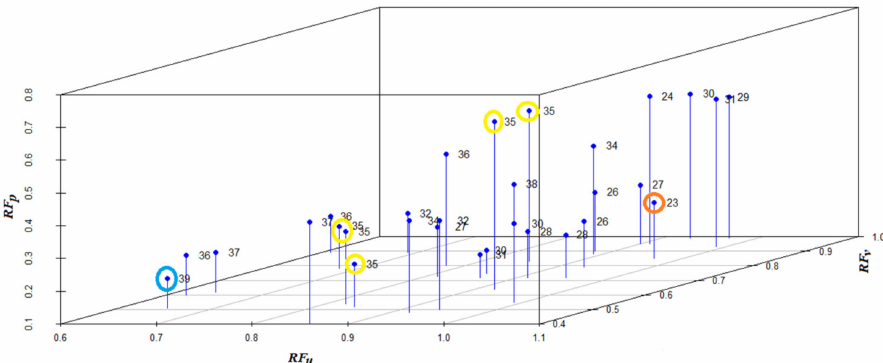
Figure 7. Behavior of tconv of the Driven-Cavity problem depending on RF s for an 11 × 11 mesh and a residual value of ε = 1 × 10 − 5